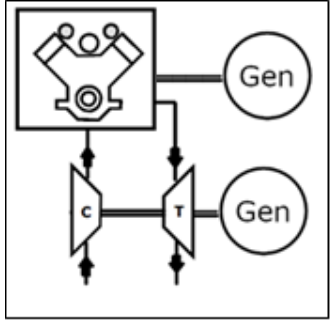
Figure 1. Turbocompound power unit scheme.